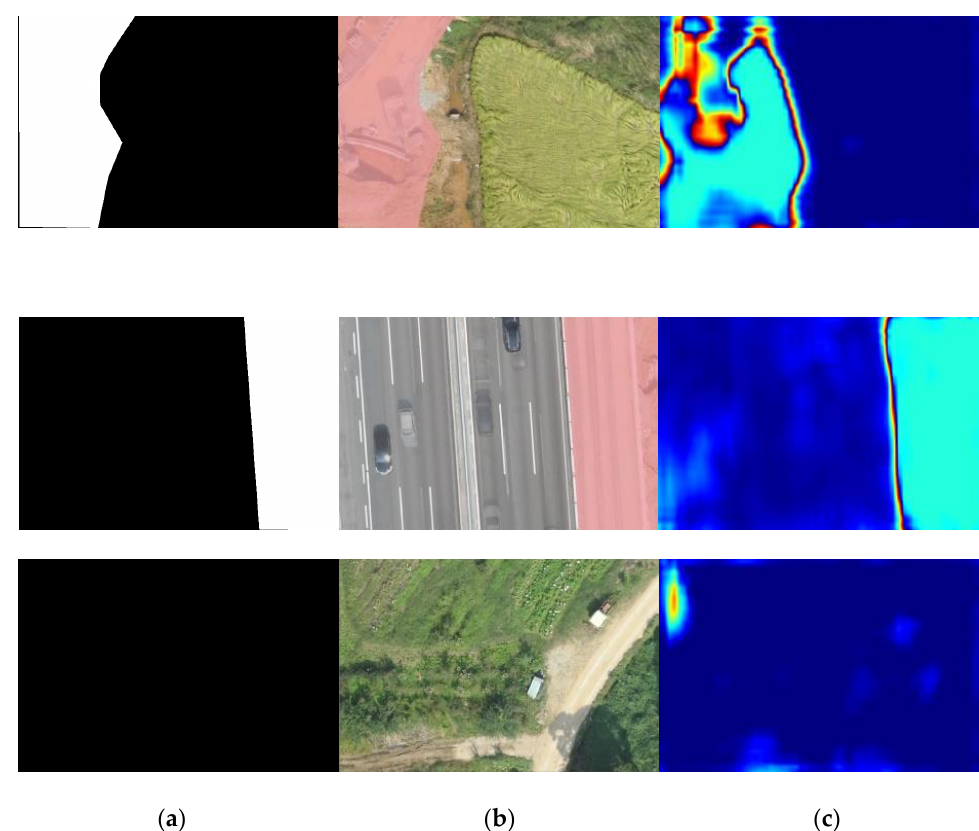
Figure 7. Experiment results for some test samples. ( a ) True changed area with visual interpretation, ( b ) overlay of true changed area and image, and ( c ) result obtained using the proposed method. The images from the original two periods shown in Figure 6 were used in this experiment.